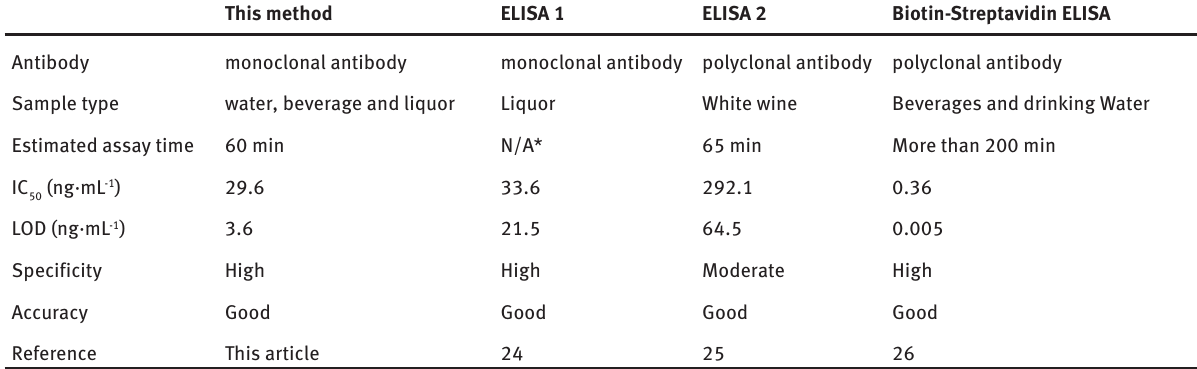
Table 5: Comparison of Several ELISA